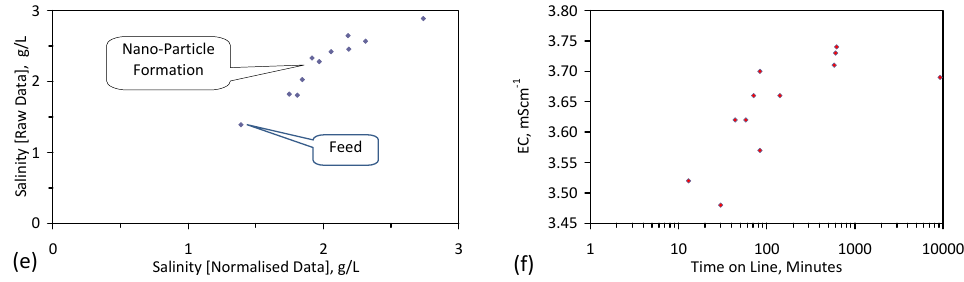
Figure C31. ZVM TPA example Trial E146. 11th Reuse; Operating Temperature: 15–20 °C; Oxidising Environment: Water volume in the reactor = 0.24 m 3 ; ZVM TPA from Trial E145 in a cartridge = 0.4 kg; Air flow = 120 L·h − 1 . ( a ) Eh vs. time; ( b ) pH vs. time; ( c ) pH vs. Eh; ( d ) Salinity vs. time; ( e ) Salinity calculated from normalised data vs. salinity calculated from raw data; ( f ) EC vs. time. The rise in absorbance is associated with a rise in EC.